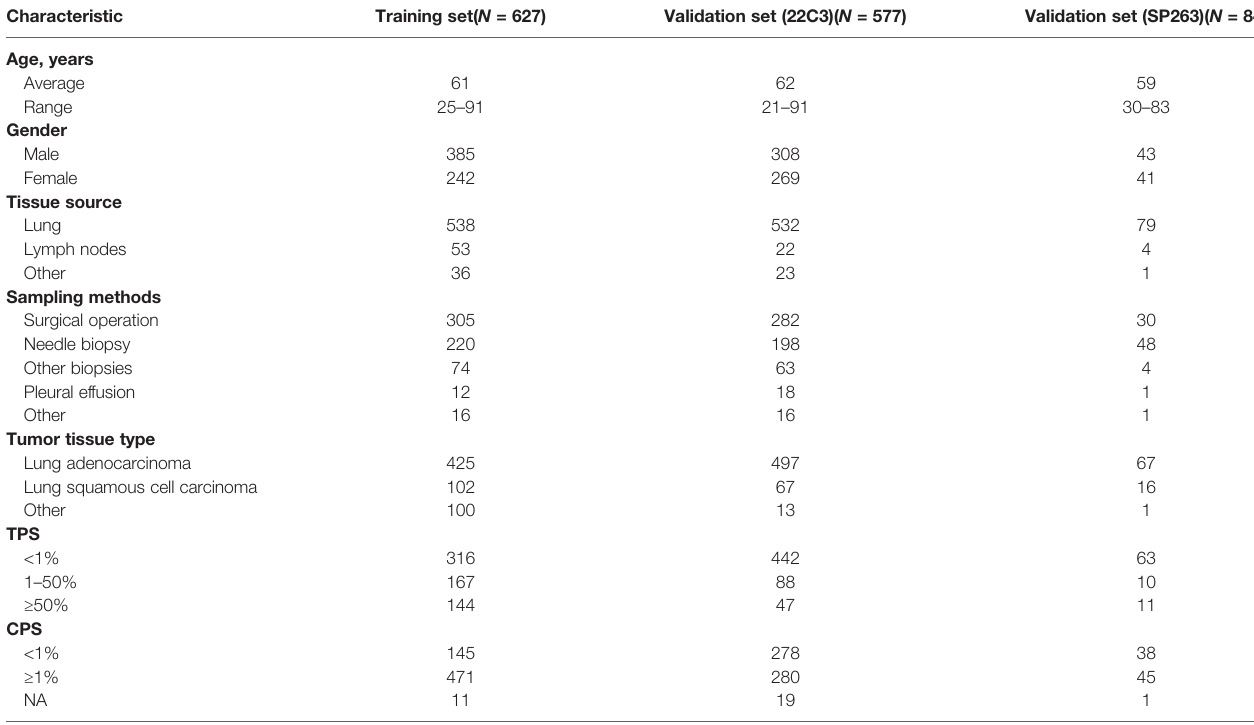
TABLE 1 | Clinicopathological characteristics of lung cancer.